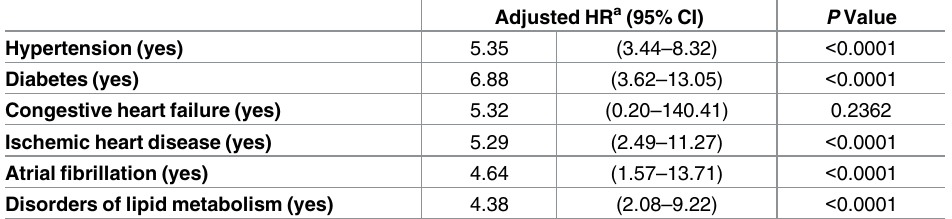
Table 3. Adjusted HR for stroke during the follow-up period for patients with NTG as compared with patients in the comparison group, stratified by different